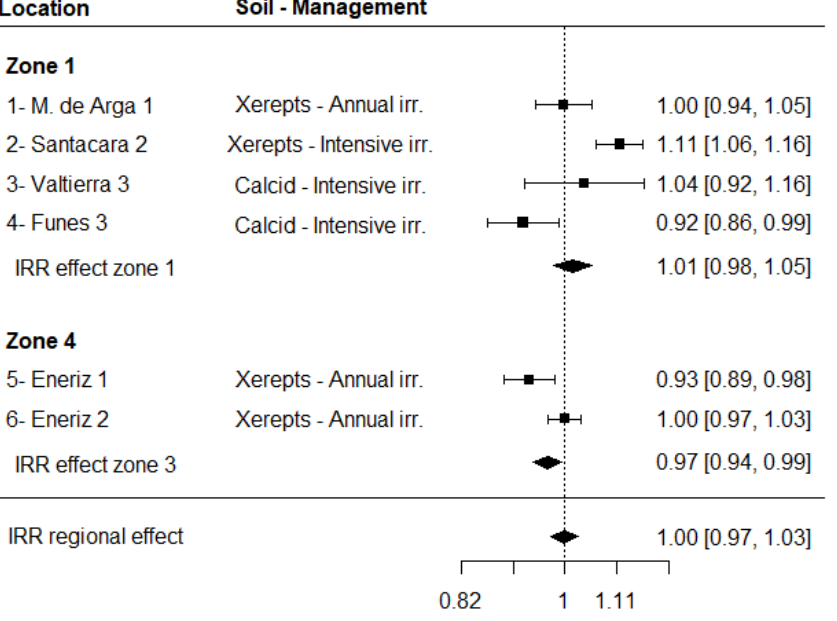
Figure 9. Response ratio (RR) of BD (0–30 cm) for the adaptive management strategy of irrigation (IRR). Zones correspond to those in Figure 1. The effect was considered significant when the 95% confidence interval (CI) of the RR did not overlap one ( α = 0.05). Soil and management column includes information about principal soil group and irrigation regime considered in each group.